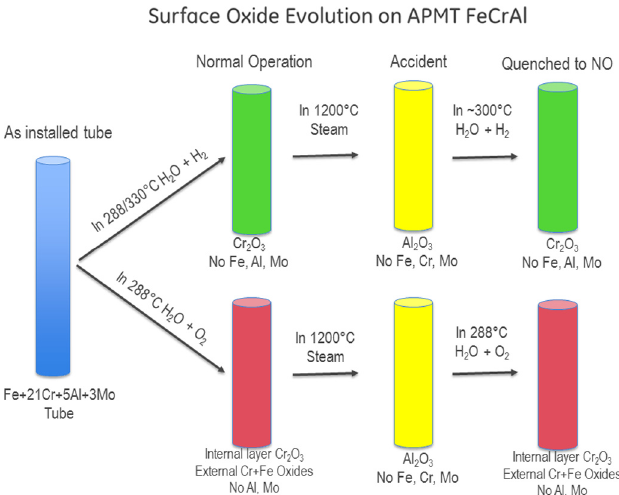
Fig. 10. Schematic representation how aluminum and chro- mium in FeCrAl react to normal operation conditions and accident conditions. Cr is bene fi cial only for normal operation conditions and Al only for superheated steam accident